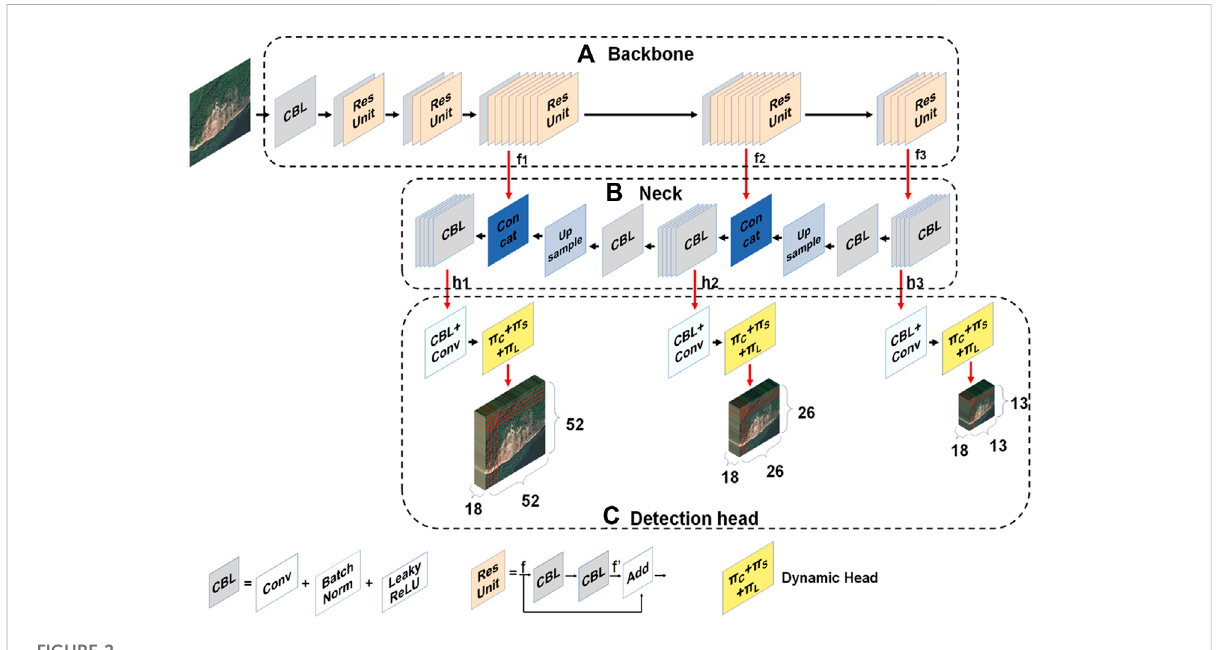
FIGURE 2 Schematic architecture of Dynahead-Yolo. (A) The details of backbone for extracting features. (B) The structure of neck for feature fusion. (C) Overview of detection head for object classi fi cation and